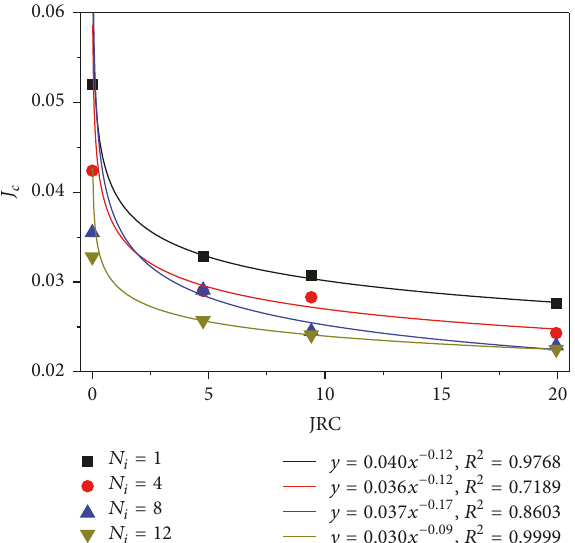
Figure 15: Relationships between 𝐽 and Re and JRC based on the data replotted from Liu et al. ([36], Figure 6